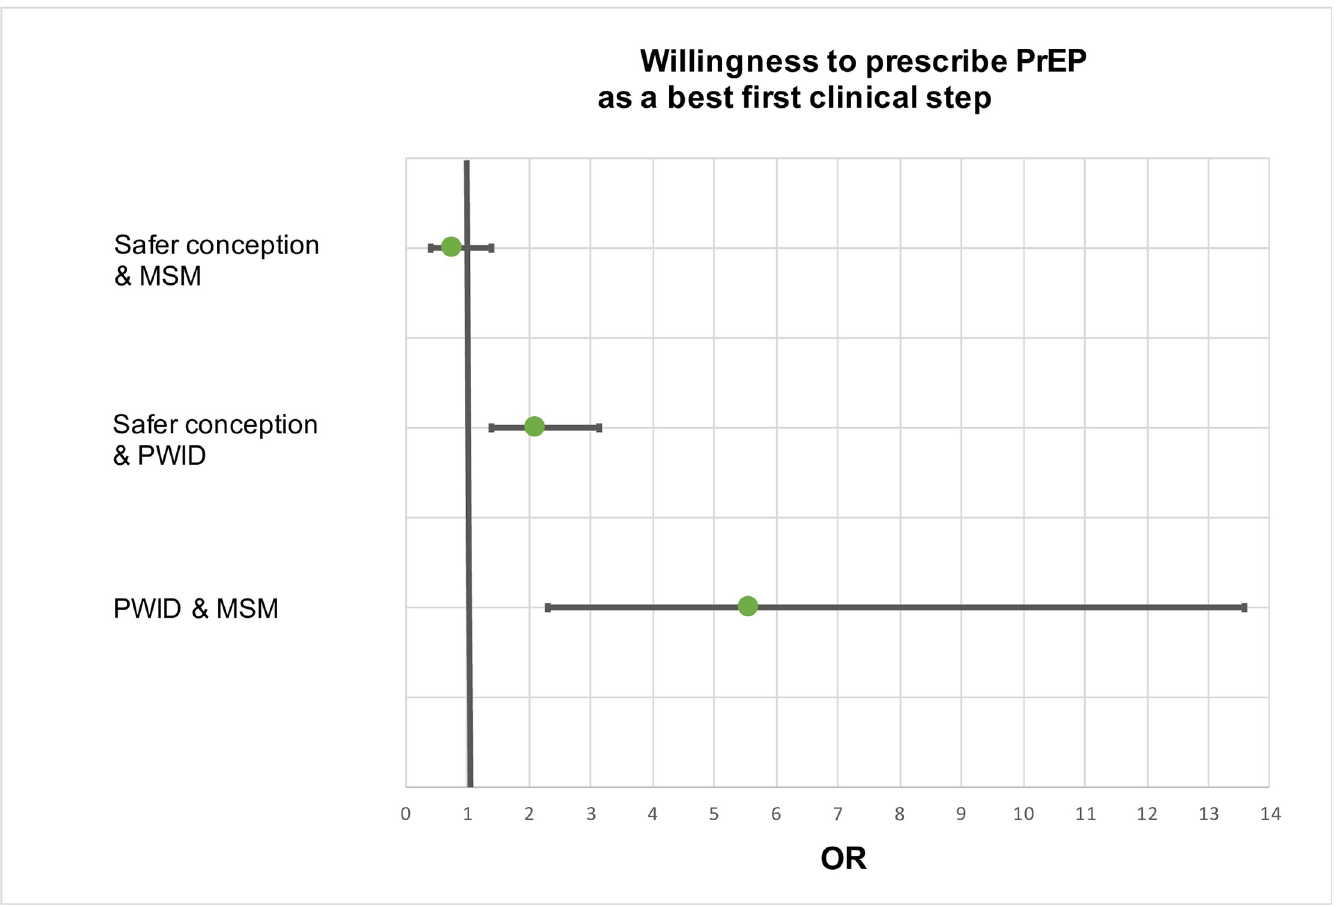
Fig 3. Multivariable logistic regression analysis on willingness to prescribe PrEP as a best first clinical step across groups vulnerable to HIV. This figure encompasses regression models comparing willingness to prescribe PrEP as a best first step in different risk scenarios–i.e. safer conception and MSM, safer conception and PWID, and PWID and MSM. MSM = Men who have sex with men; PWID = people who inject